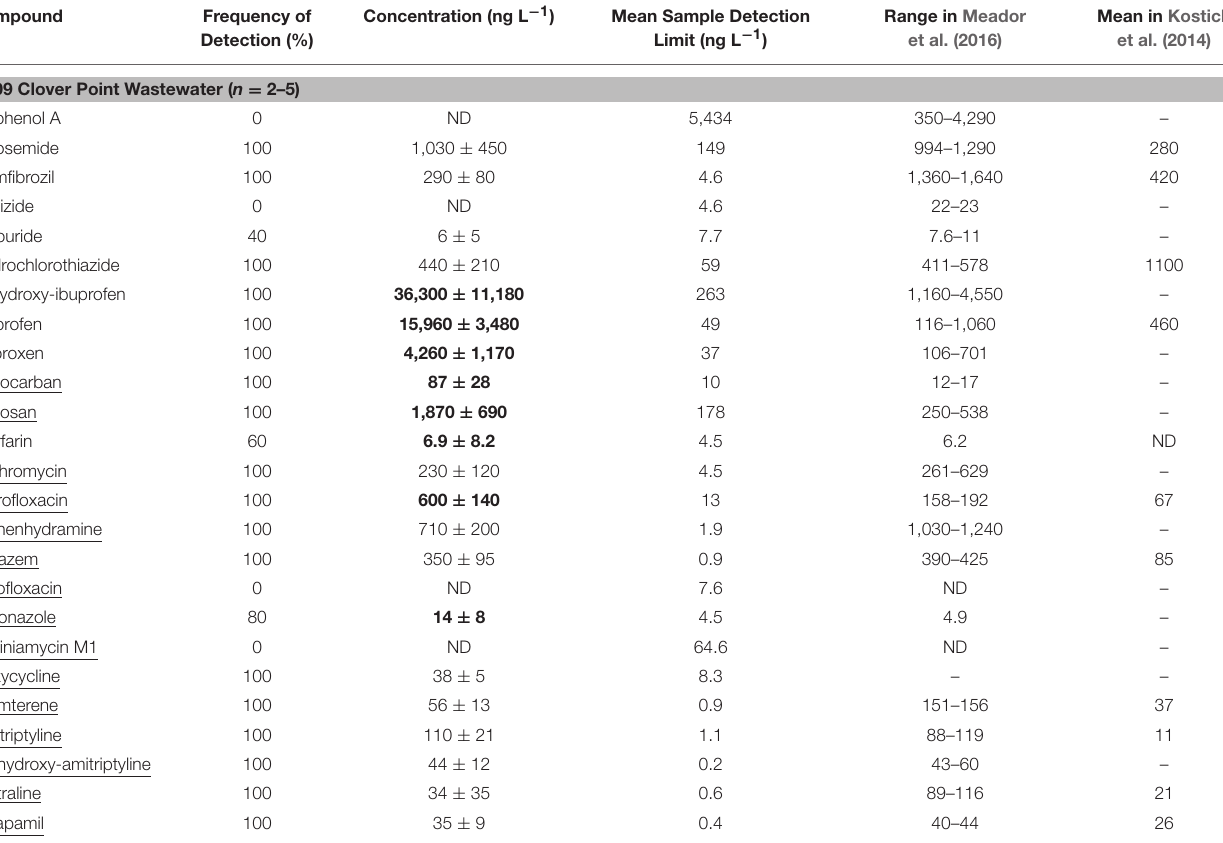
TABLE 4 | Concentration (mean ± standard deviation) of detected PPCPs in CLO wastewater (full results see Lowe 2011) in November 2009.